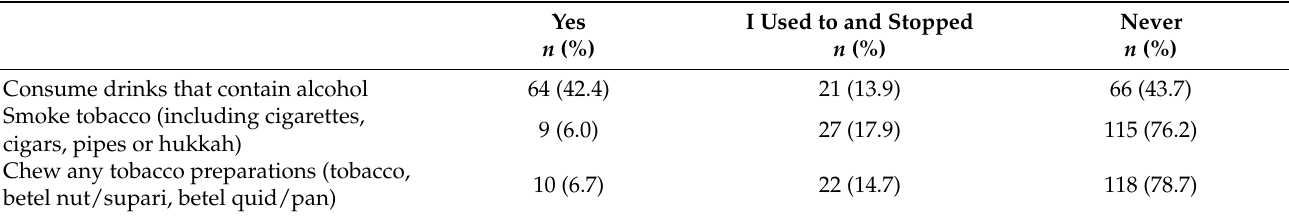
Table 5. Self-reported behaviours with alcohol and tobacco preparations.